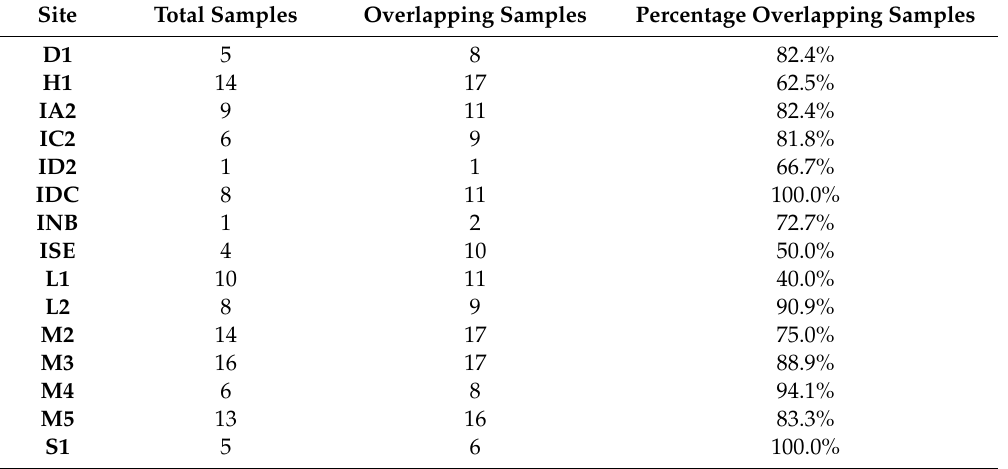
Table 2. Summary statistics for each site (Figure 2) showing the percentage of points overlapping as well as the count.